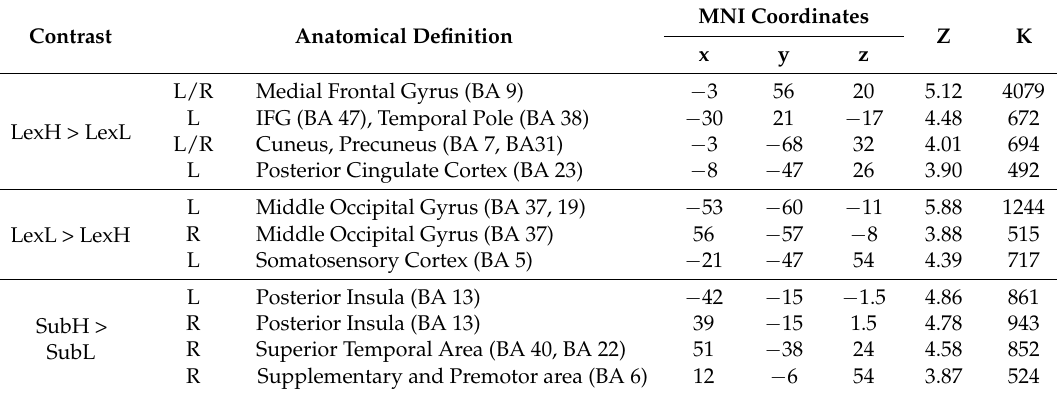
Table 2. Results for two main contrasts of lexical and sublexical arousal.